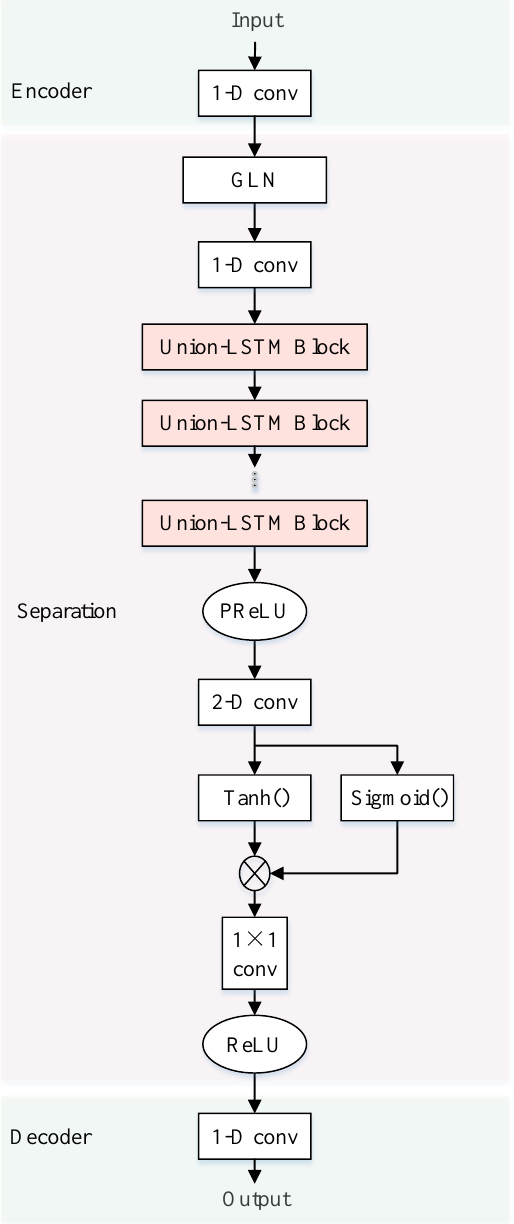
Figure 4. Stacked-LSTM separation network